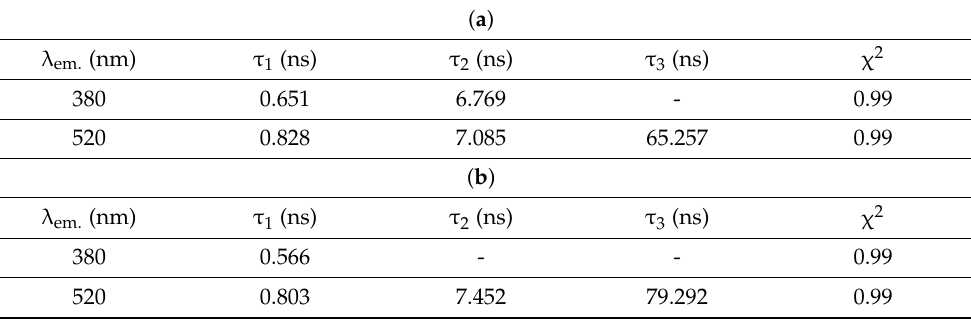
Table 2. ( a ) PL Decay of ZnO nanocrystals dispersed in ethanol under λ ex. = 320 nm using NanoLED. ( b ) PL Decay of ZnO:Ho 3+ (0.5 mol%) nanostructures dispersed in ethanol under λ ex. = 320 nm using